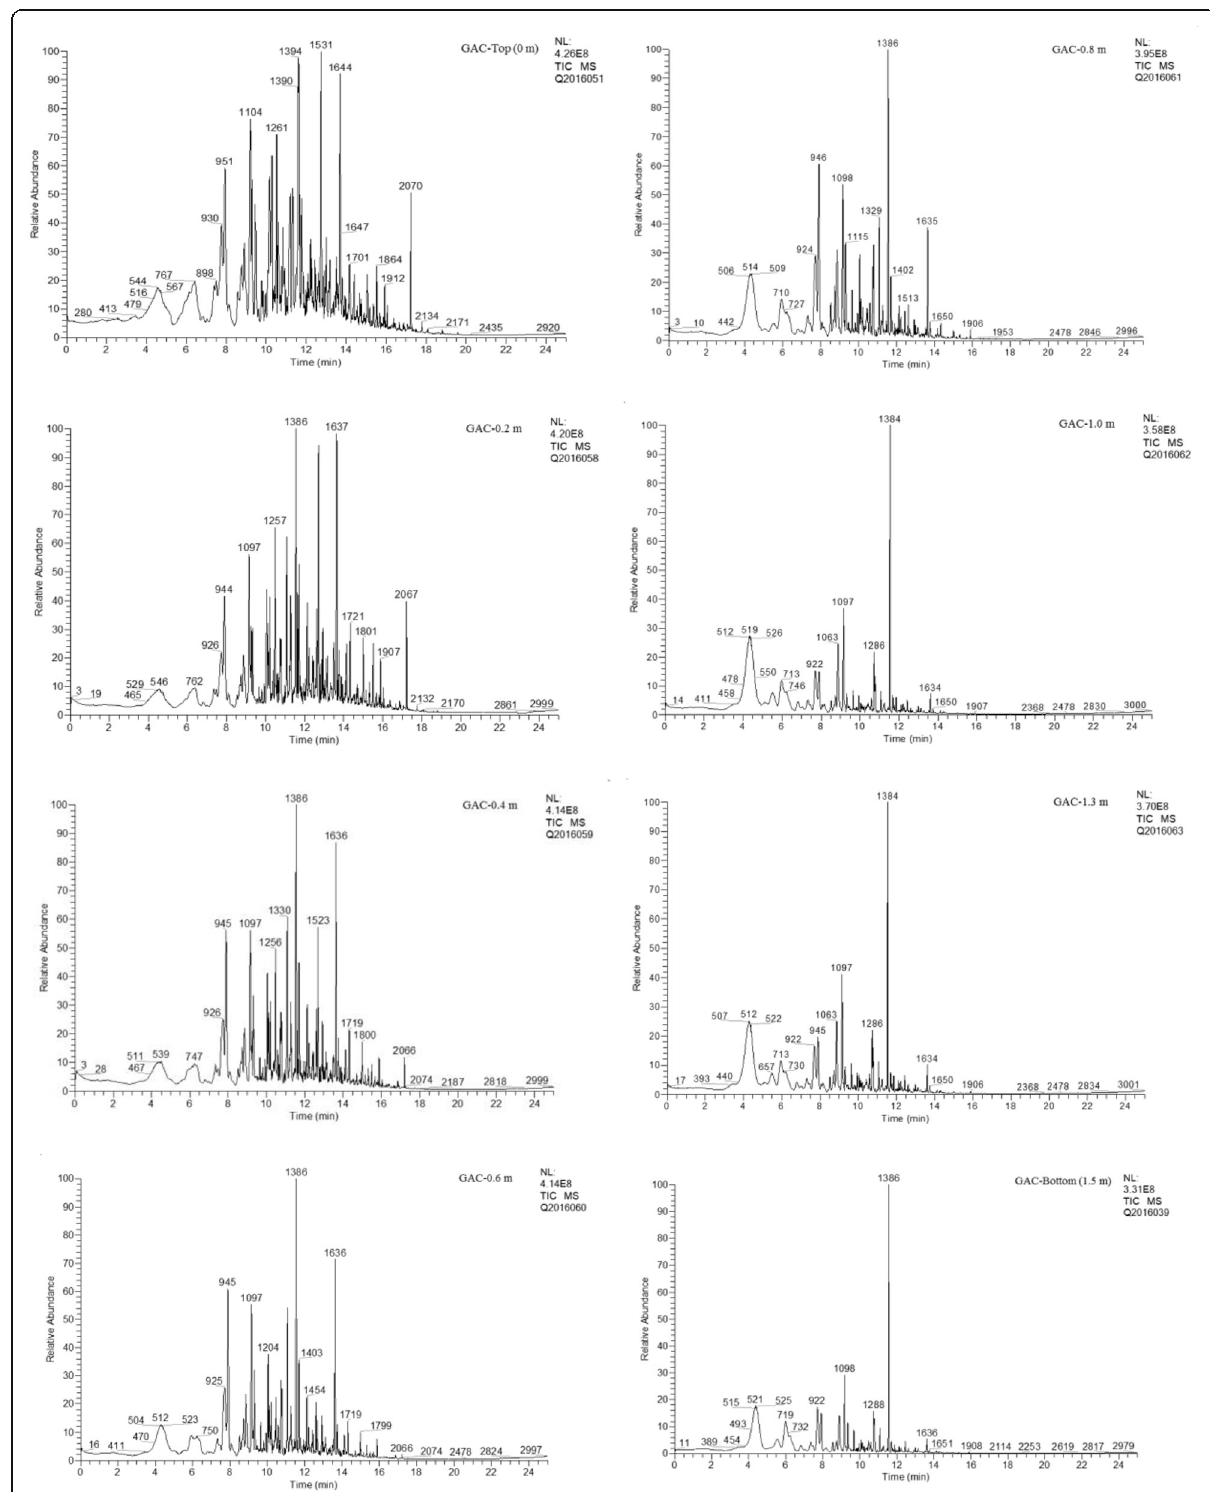
Fig. 12 TD-GC/MS chromatograms of the different GAC samples in the rum filter (adapted from Crespo Sariol et al. (2017b;